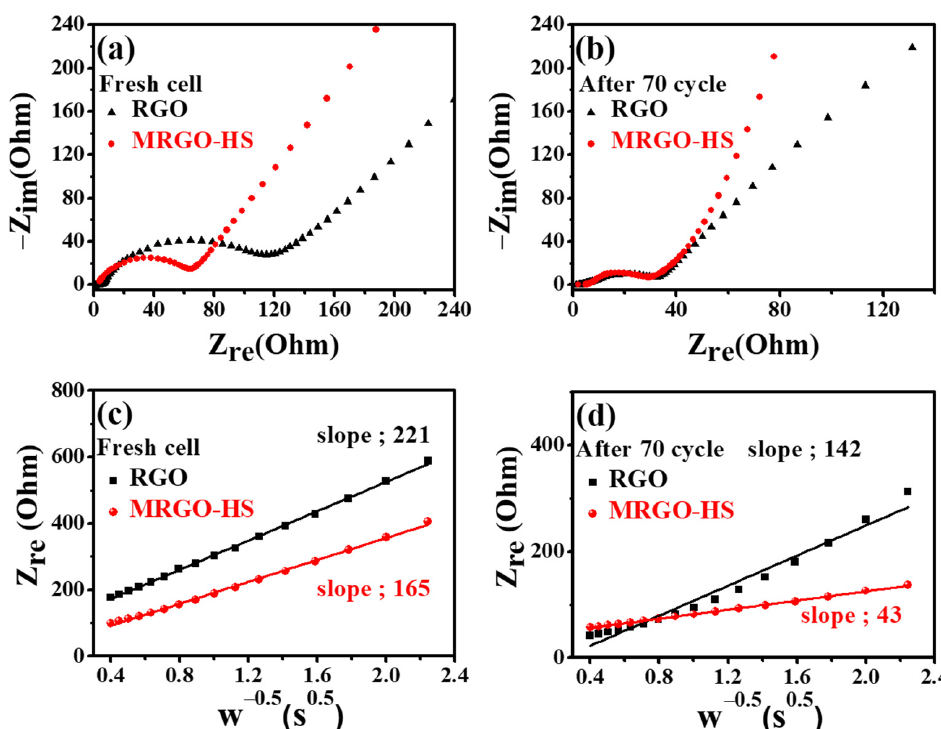
Figure 12. ( a ) Nyquist plots for a fresh cell and ( b ) Nyquist plots after 70 cycles. Warburg plots for a fresh cell ( c ) and after 70 cycles ( d ).